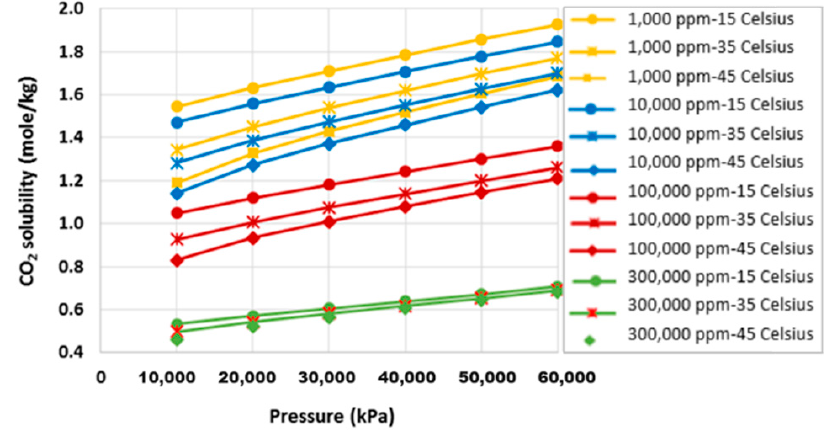
Figure 2. CO 2 solubility as a function of pressure, temperature and salinity, generated using Zhao et al. [20].